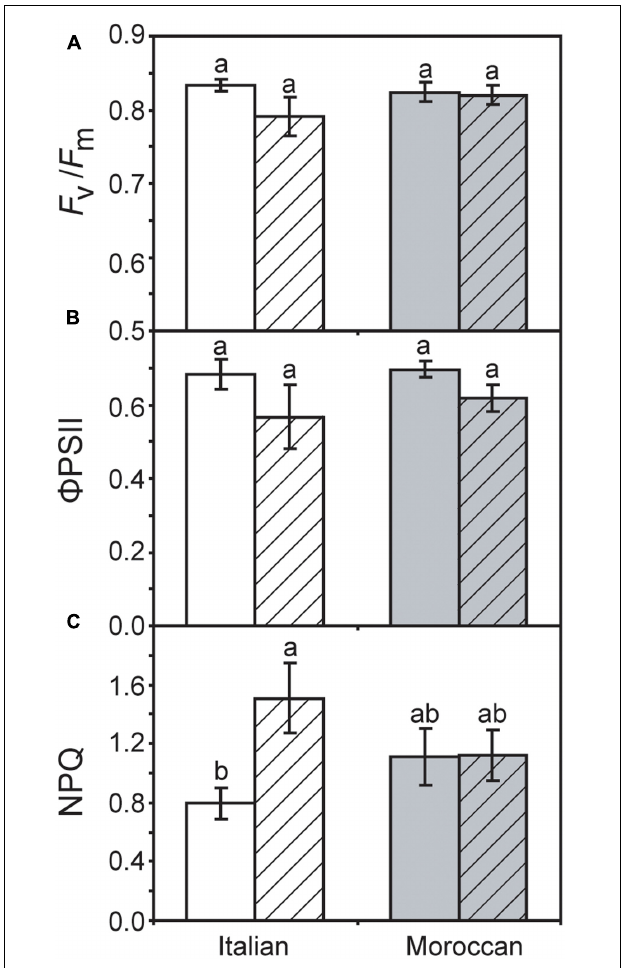
FIGURE 3 | Chlorophyll fluorescence measurements of Moroccan (gray) and Italian (white) A. donax ecotypes grown in the field under irrigated control (open) and rain-fed drought (hatched) conditions: (A) maximum quantum efficiency of PSII ( F v / F m ); (B) actual quantum efficiency of PSII ( (cid:56) PSII), and; (C) non-photochemical quenching (NPQ). Error bars indicate one standard error either side of the mean ( n = 6). Letters indicate homogenous groups determined using a one-way ANOVA and LSD post hoc